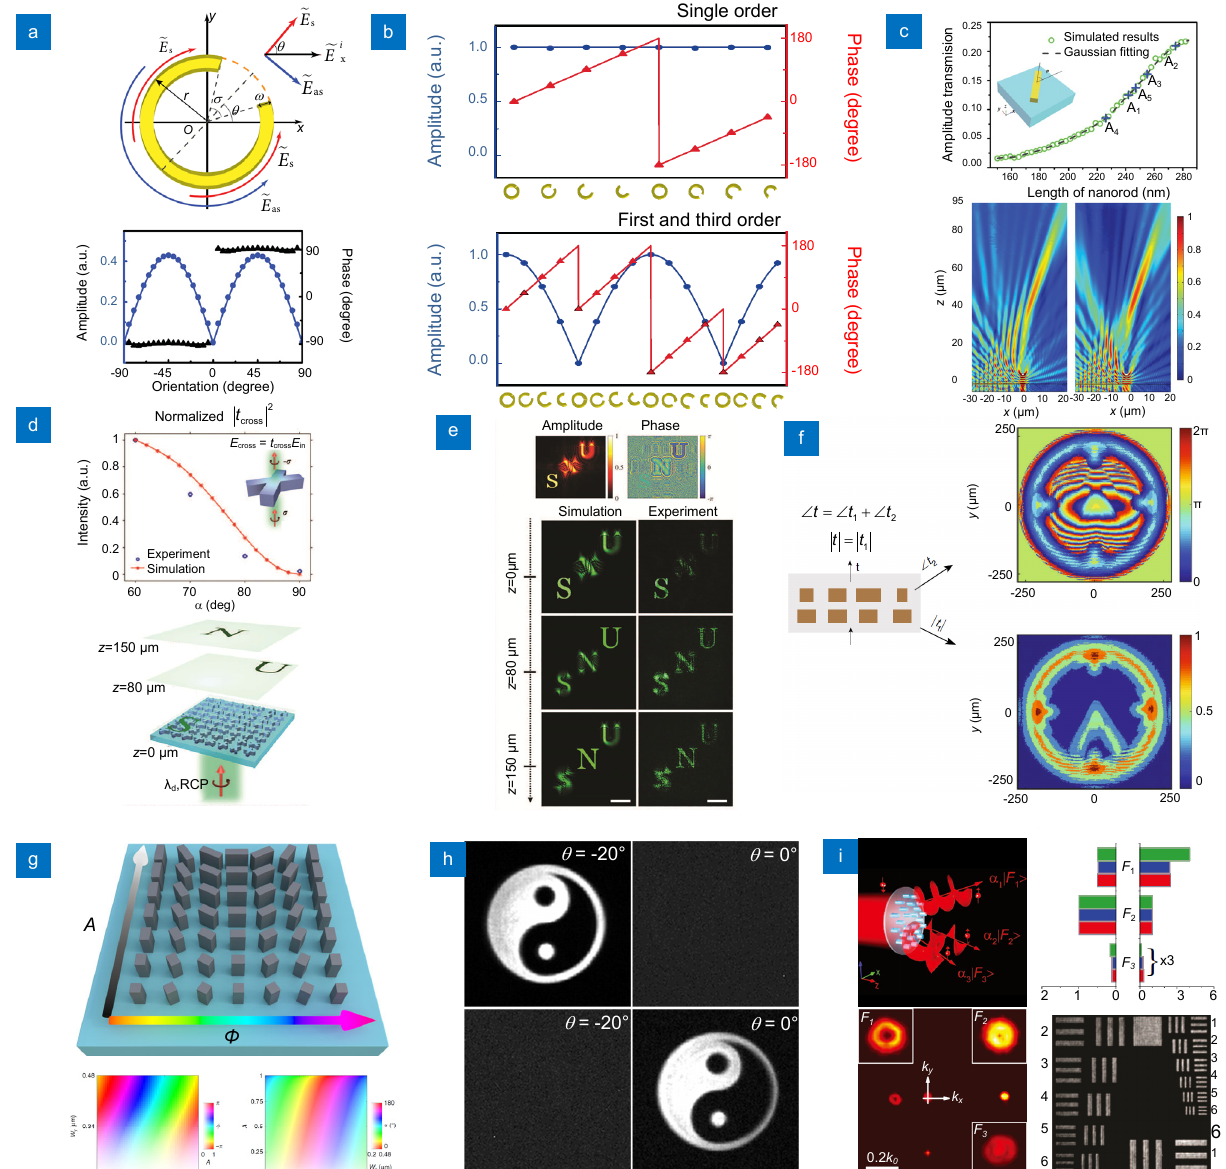
Fig. 2 | ( a ) Schematic of the C-shaped antenna used to control the phase and amplitude of linearly polarized light simultaneously (upper panel) and simulated transmission amplitude and phase of an antenna array for different orientation angle θ (lower panel). ( b ) Simulated amplitude and phase of the transmitted y -polarized light for different antennas with different orientation angle θ and geometrical parameters under x -polarized normal incidence. ( c ) Upper panel: simulated amplitude of the converted CP light for different nanorods with different lengths. Inset shows the schematic of the gold nanorod. Lower panels: simulated electric field distributions of the Airy beams with simplified amplitude modulation (left) and without am- plitude modulation (right). ( d ) Simulated and measured cross-polarized transmission for X-shaped structures with different intersection angles (upper panel) and schematic of the designed hologram (lower panel). ( e ) Upper panels: amplitude and phase profiles of the designed hologram. Lower panels: simulated and measured holographic images at proper image planes. ( f ) Left panel: schematic of the bilayer metasurface that can generate complex amplitude holograms. Right panels: phase (upper) and amplitude (lower) profiles of the designed hologram. ( g ) Upper panel: schematic of the structures used to independently and completely control the transmitted phase and amplitude. Lower panels: simulated phase and amplitude for structures with different lengths and rotation angles. ( h ) Measured holographic images at different observation angles. The upper two images correspond to the metasurface with a phase gradient. The lower two images correspond to the metasurface with same intensity distributions as the upper metasurface but without phase gradient. ( i ) Left panels: schematic of the energy tailorable multifunctional metasurface (upper) and measured light distributions of three vortex beams with order of 3, 1, 0, respectively (lower). Right panels: the designed (red), calcu- lated (blue) and measured (green) energies of each functionality for different samples (upper) and measured image of 1951 USAF resolution test target realized by a metasurface (lower). Figure reproduced from: (a–b) ref. 53 , Wiley-VCH; (c) ref. 58 , Wiley-VCH; (d–e) ref. 60 , Royal Society of Chemistry; (f) ref. 61 , Nature Publishing Group; (g–h) ref. 62 , Nature Publishing Group; (i) ref. 63 ,